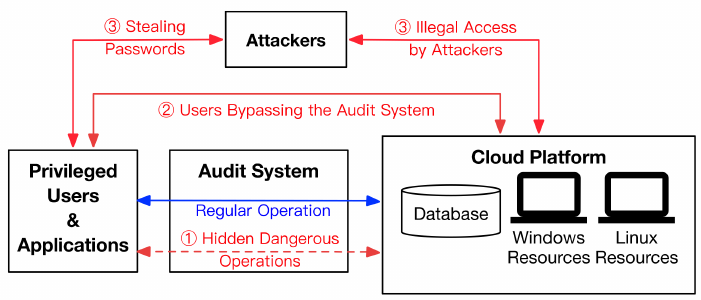
Figure 8. Threats of privileged accessing process in cloud